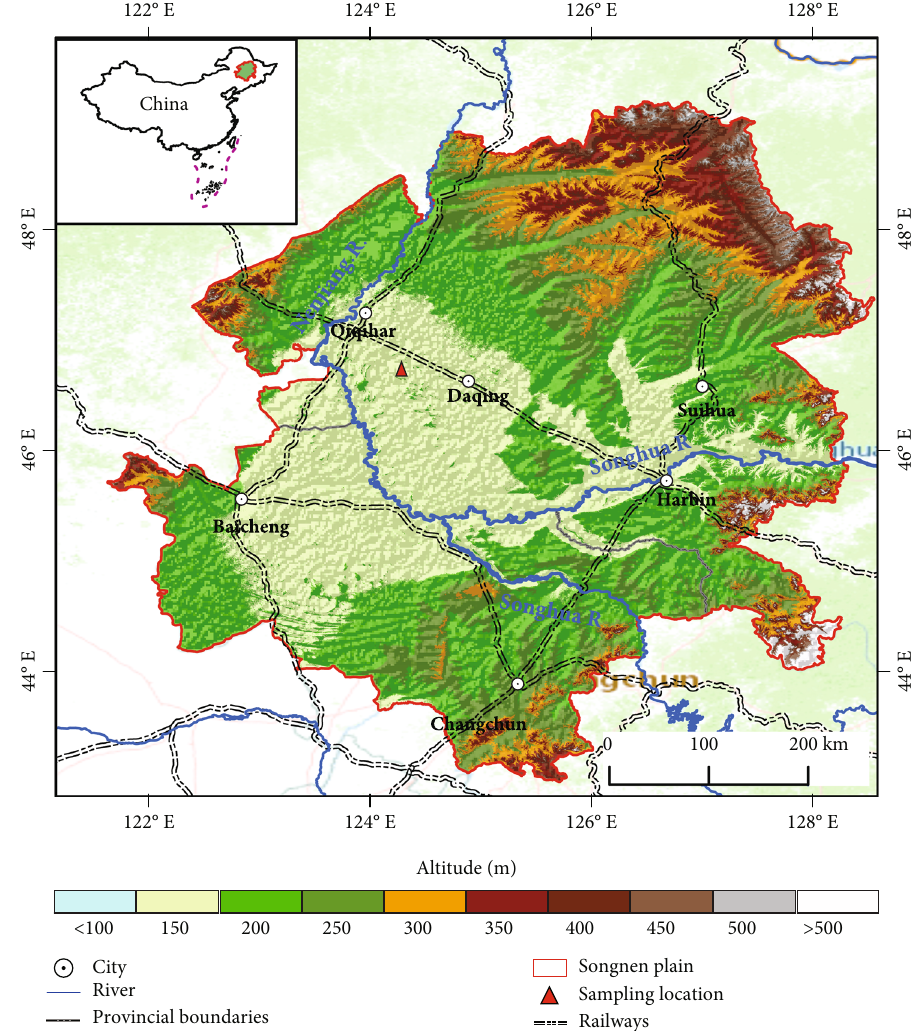
Figure 1: Location of carbonate saline soil sampling site.